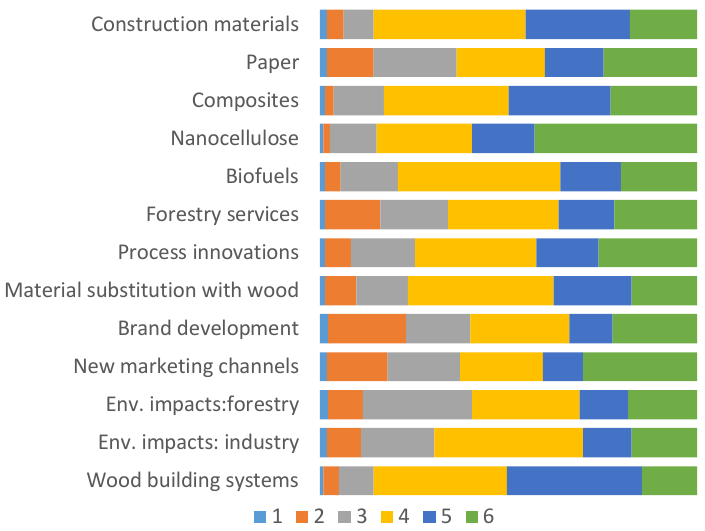
Figure 3. Respondent distribution to the statement: “Since the year 2000, forest sector companies have produced significant innovations related to…” (Scale from 1 = Strongly disagree, to 5 = Strongly agree, 6 = I don’t know).